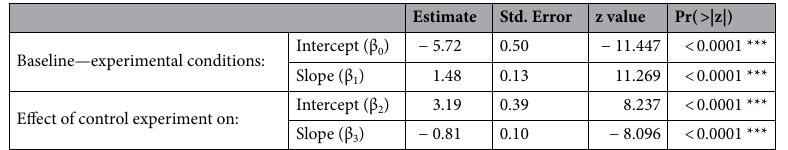
Table 3. All coefficients of the GLMM for the fixed factors in the model used to control the effect of the horizontal distance and the relative P value are shown (Baseline: experimental conditions).*P < 0.05. **P < 0.01. ***P <